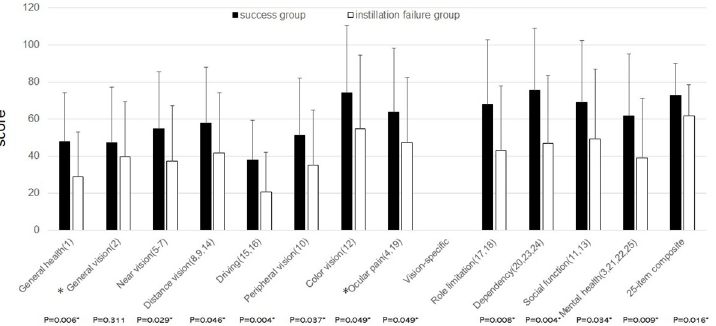
Fig 2. Correlation between NEI-VFQ25 score and rate of instillation failure. Patients belonging to the success group showed significantly higher scores than those in the failure group except for items with � (Mann-Whitney T- test). The number in parentheses represents the item number. NEI-VFQ 25: National Eye Institute Visual Function Questionnaire